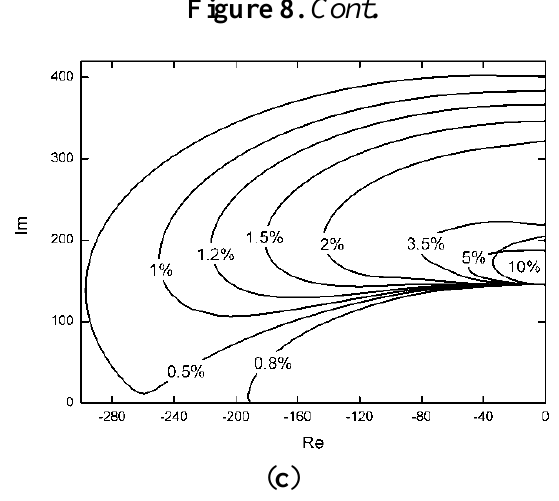
Figure 9. Relationship between damping ratio and error ∆ k